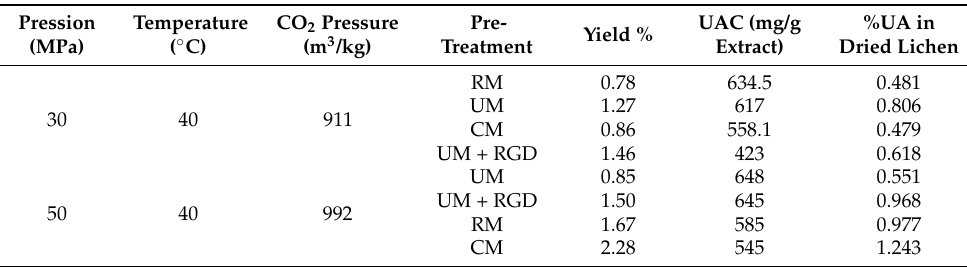
Table 10. The influence of lichen thalli pre-treatment and extraction conditions on usnic acid (UA) content and extraction yield in UB-SFE